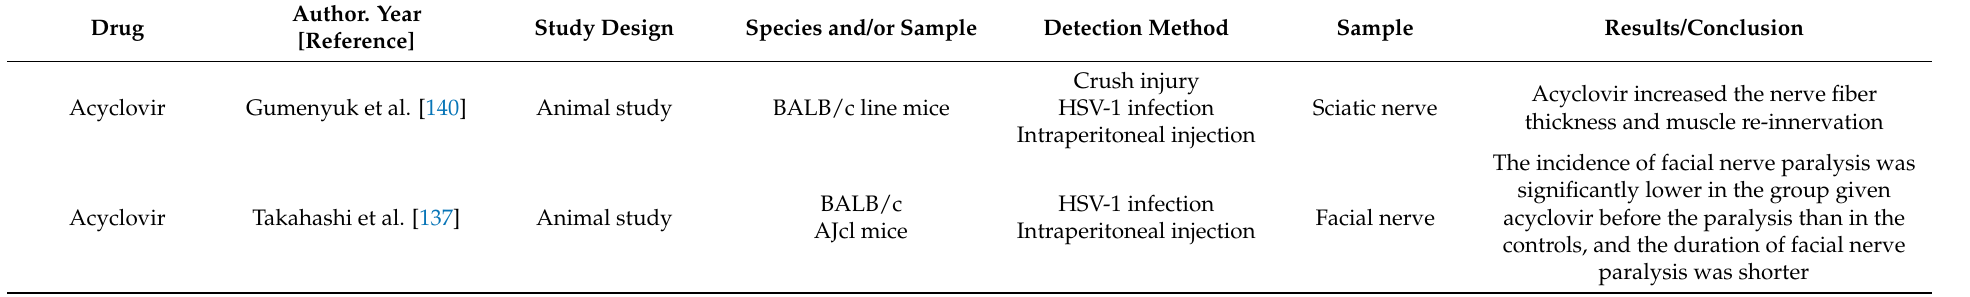
Table 12. Summary of studies assessing antiviral treatment of peripheral nerve